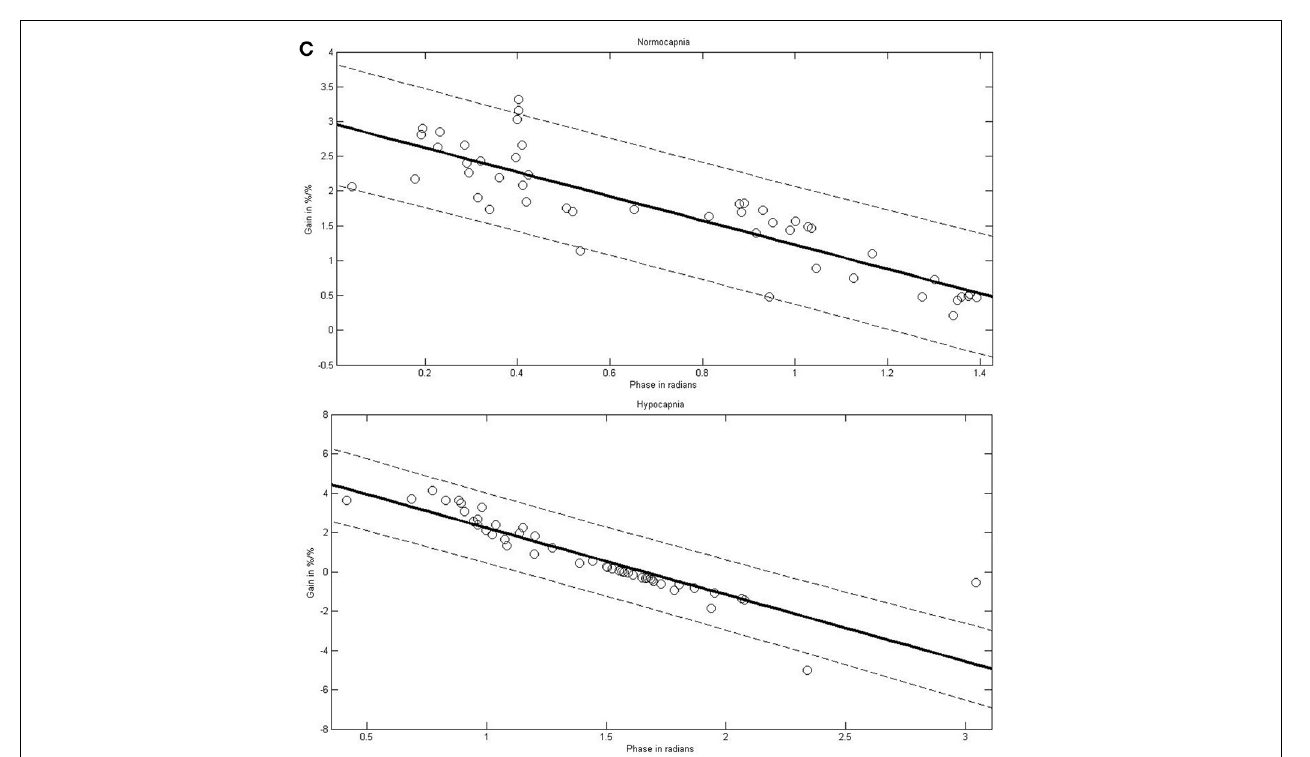
FIGURE 2 | Linear correlations between phase and gain in different frequency ranges [sub very low frequencies (sVLF; A), very low frequencies (VLF; B), and low frequencies (LF; C)] in normocapnia and hypocapnia. Correlation line (solid) with 95% confidence interval